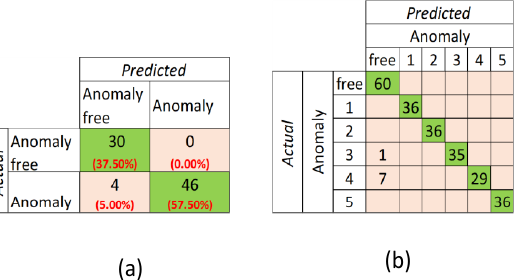
Figure 13. Confusion matrix of WM experiments ( a ) via CC-AD/( b ) via ANN-ADC.